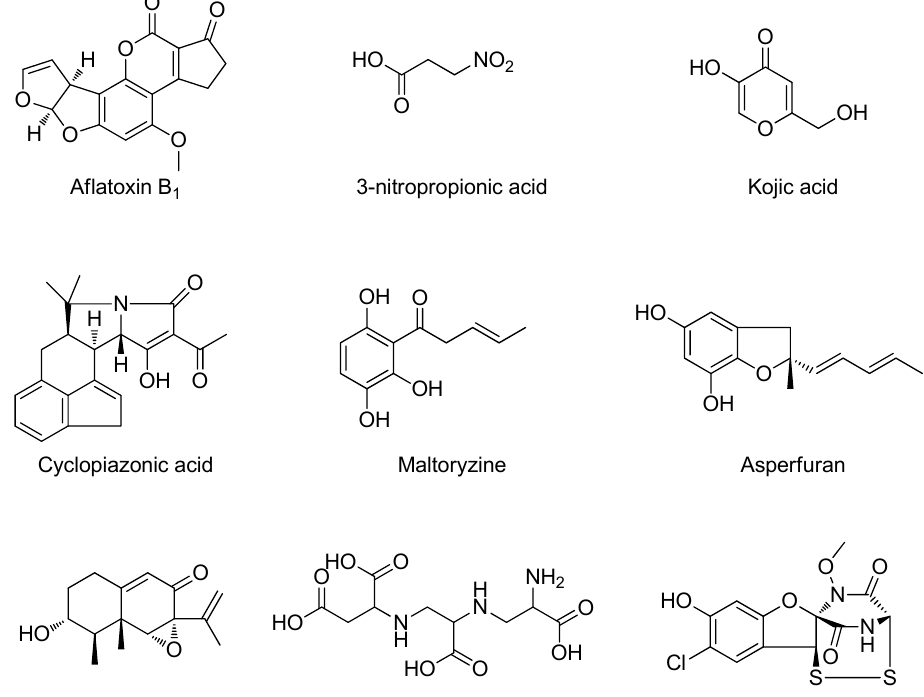
Figure 1. Known compounds from Aspergillus flavus or A.